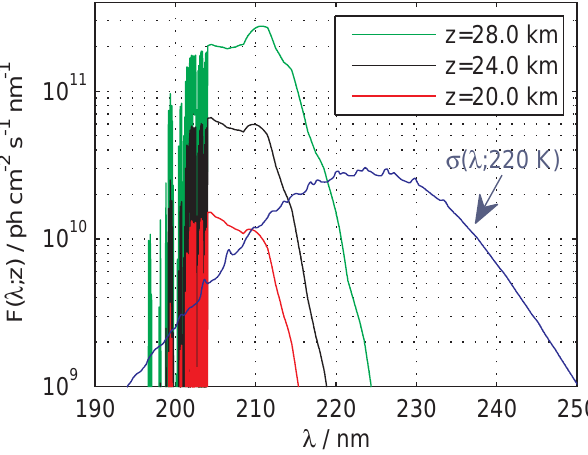
Fig. 4. The actinic flux of McLinden et al. (2002) at three different altitudes. The calculated absorption cross section for OCS at 220K is also shown (multiplied by 10 29 and given in units of cm 2 ).